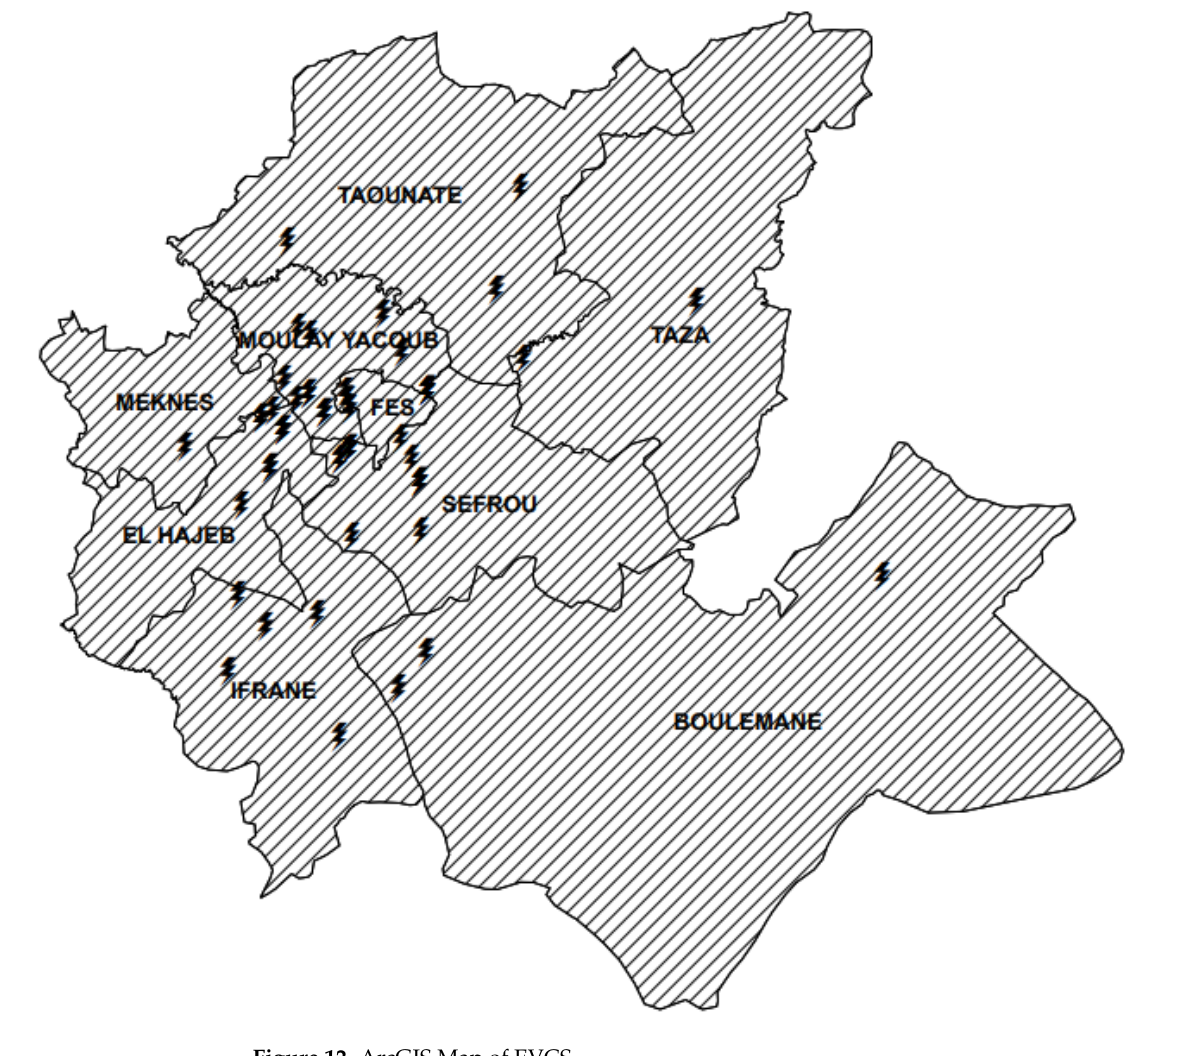
Figure 12. ArcGIS Map of EVCS.